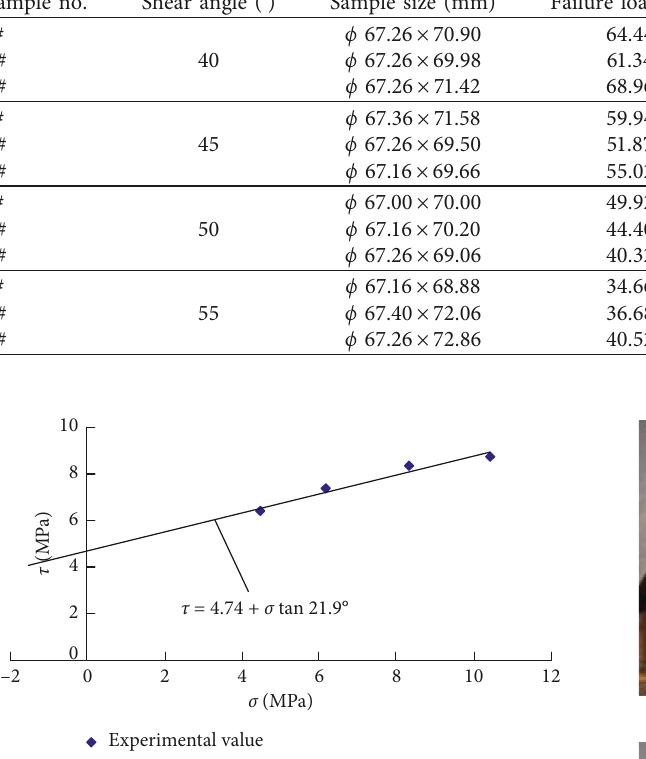
Figure 2: Linear regression strength curve for mudstone.